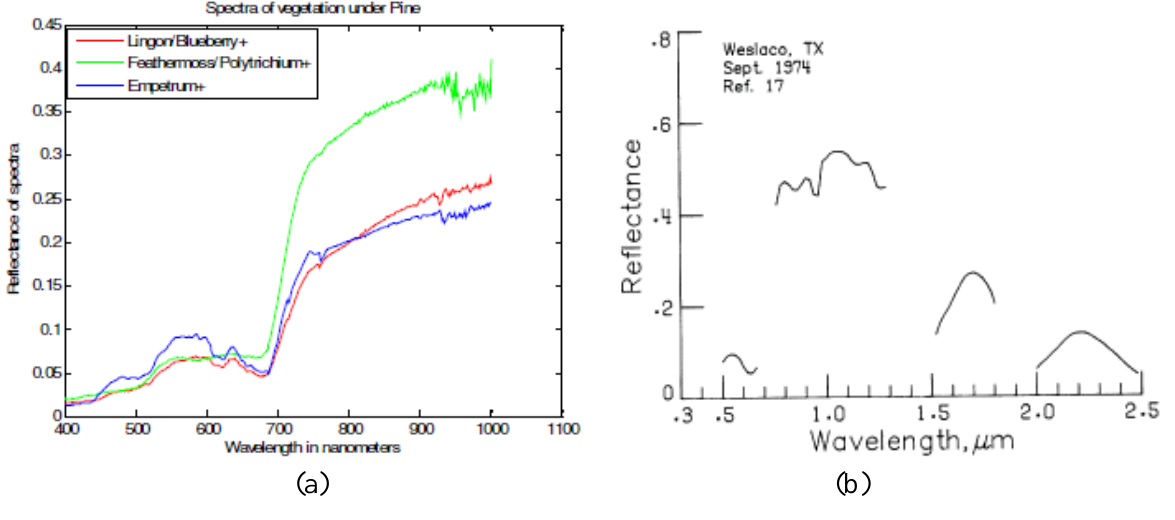
Figure 1. Spectral reflectance curves of different fruit and nut crops. Spectral reflectance curve for: (a) blueberry, feathermoss crowberry [39]; (b) redblush citrus [52]; (c) orange leaves [52]; (d) prickly pear [52]; (e) peach leaves